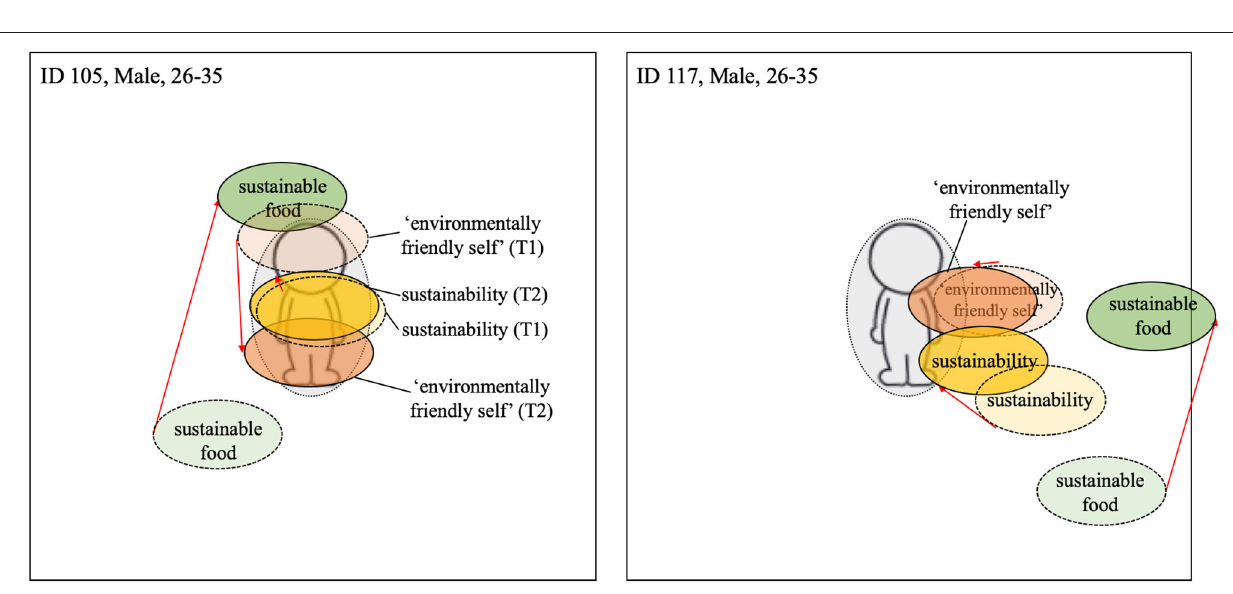
FIGURE 5 | Visualization for centrality of identity—“Easy”and small changes; Dashed line = T1; solid line and darker coloring = T2; Red arrow indicates change from T1 to T2 (the colors were added after the